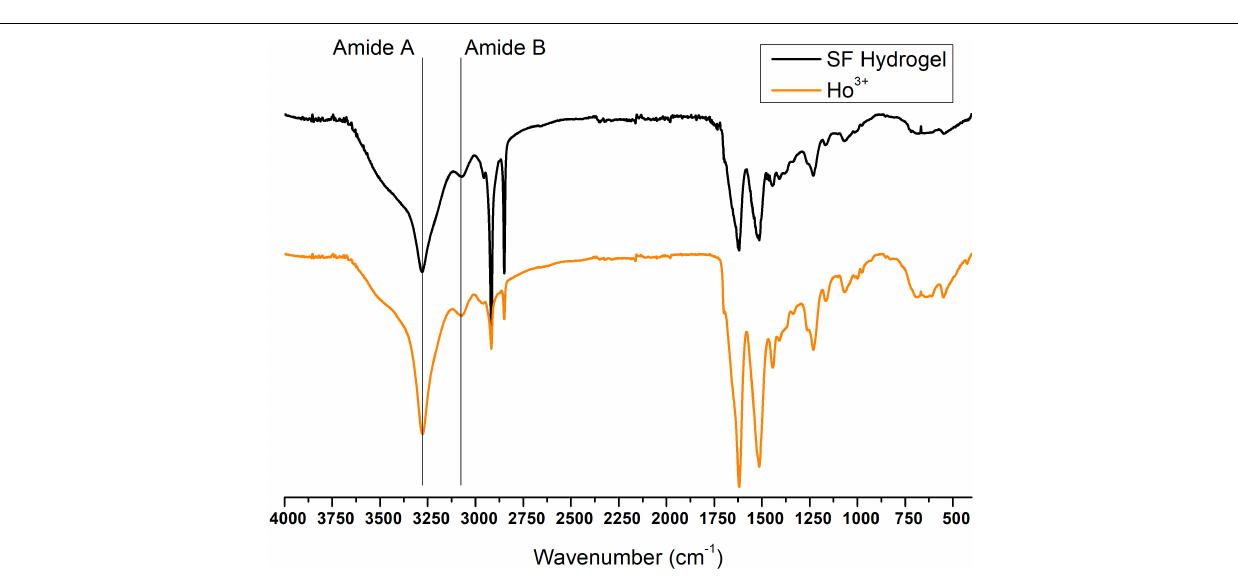
FIGURE 11 | ATR-FTIR spectra of Ho + 3 /SF hydrogel obtained by spontaneous gelation of the dialyzed solution of SF dissolved in HoCl 3 according to the modified Ajisawa’s